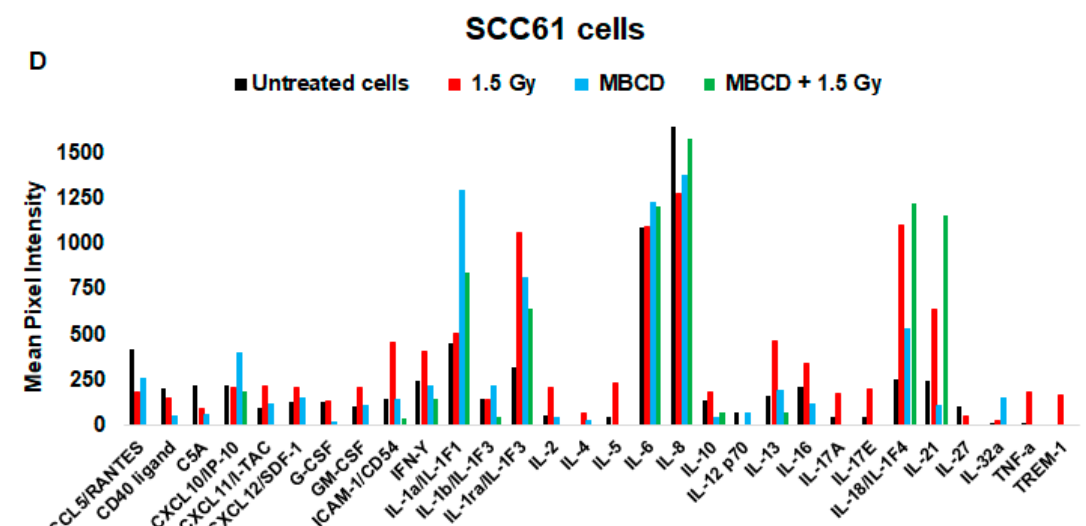
Figure 4. Role of lipid raft formation in radiosensitive SCC61 cells: SCC61 donor cells were preincubated for 30 min with 4 mM methyl- β -cyclodextrin (MBCD; lipid raft disruptor) before irradiation in the presence of MBCD. After irradiation, the medium was removed and ( A ) clonogenic survival was determinedindonorcellsandinrecipientcells. ( B )Thenumberofmicronucleipercellwasdeterminedin donor cells in the presence or absence of MBCD and in their corresponding recipient cells. ( C ) Apoptosis was measured by a TUNEL assay in SCC61 donor cells preincubated or not with 4 mM MBCD for 30 min before irradiation. The results are the mean ± SD of three experiments performed in triplicate. * p < 0.05, ** p < 0.01, and *** p < 0.001 compared with cells treated only with radiation. ( D ) The expression of cytokines secreted in conditioned medium from untreated, irradiated (1.5 Gy), and MBCD + irradiated SCC61 cells was evaluated using the Human Cytokine Array (Proteome Profiler Array; R&D Systems, Minneapolis, MN, USA). For each cytokine, ImageJ software was used to determine pixel